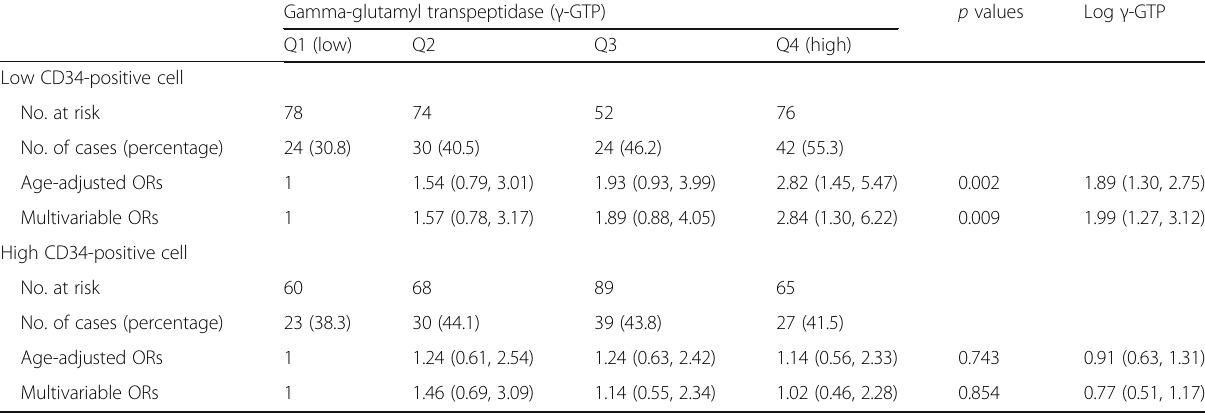
Table 4 Odds ratios (ORs) and 95% confidence intervals (CIs) for hypertension by circulating CD34-positive cell